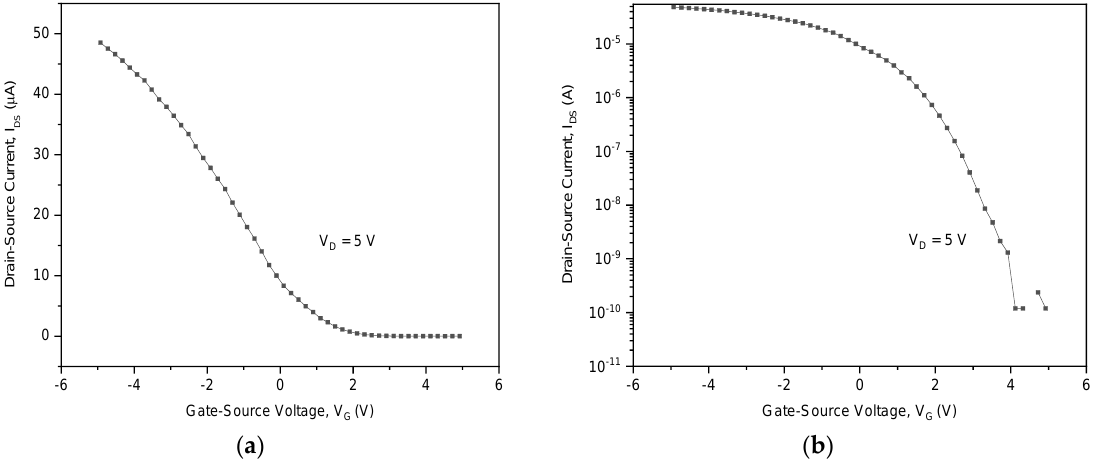
Figure 8. Electrical characterisation results of the CoMoCAT SG 65 SWCNTs: ( a ) transfer characteristics; ( b ) I on /I off ratio is ~10 5 .